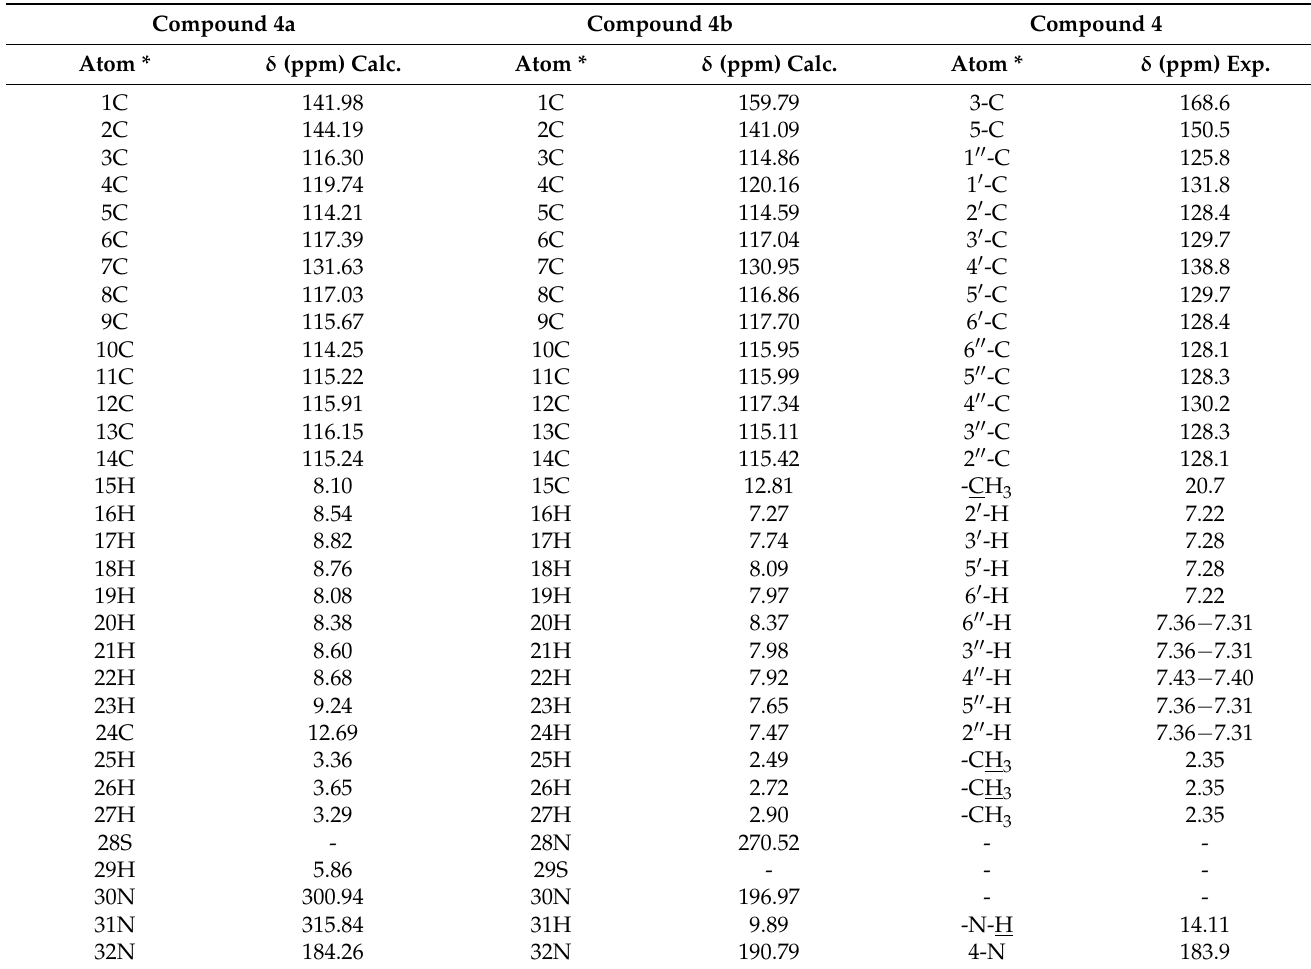
Table 1. Calculated NMR chemical shifts in ppm with TMS (for H and C atoms) and NH3 standards (for N atoms) by the GIAO method at the B3LYP/6-31+G (d, p) level of theory and experimentally determined. Compound 4b Compound